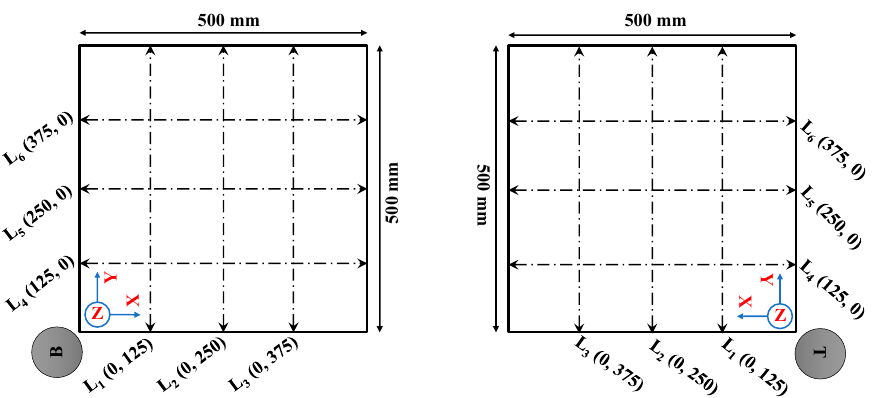
Figure 4. Visualization of the measurement lines for calculating JRC, B signifies the bottom and T is the top part of the sample.